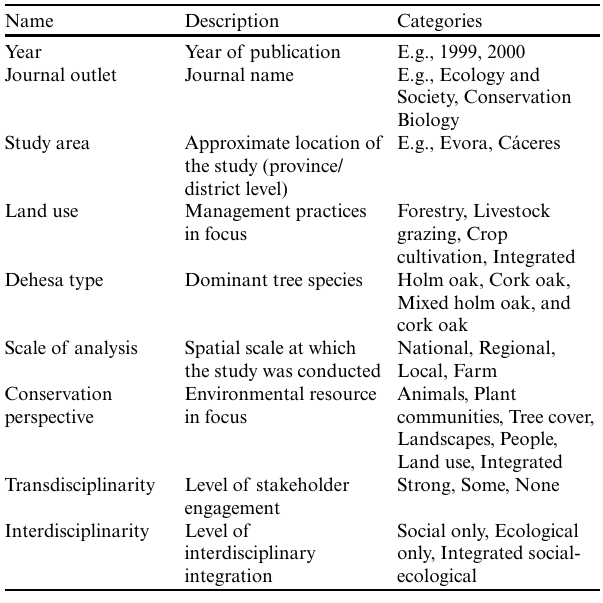
Table 1 . Categories used for coding the study